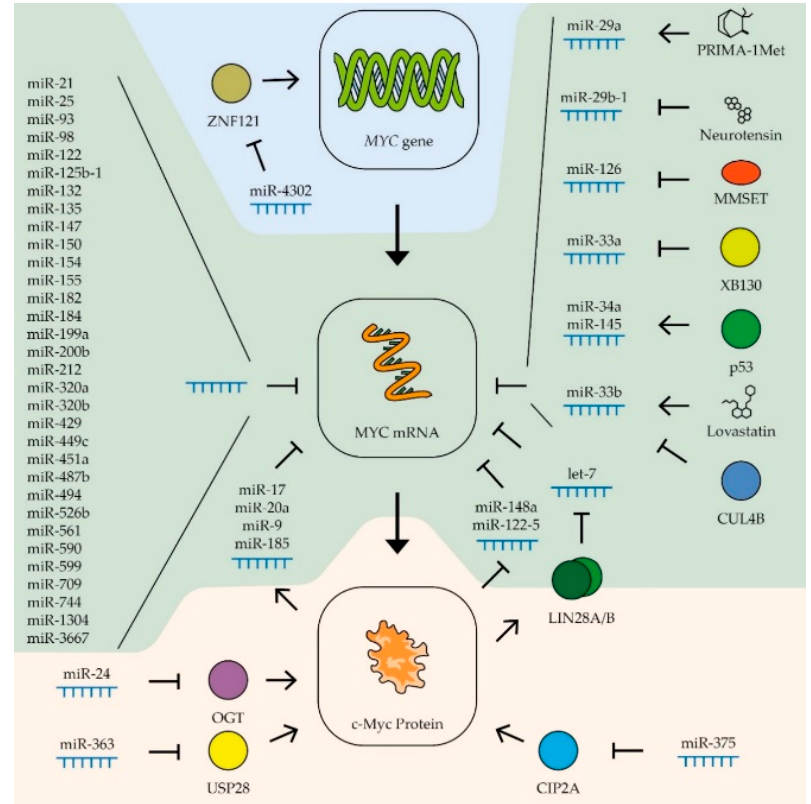
Figure 3. Control of MYC expression by miRNAs. Schematic representation of miRNAs’ influence on MYC gene transcription (blue zone), MYC mRNA (green zone), and c-Myc protein stability (yellow zone). Colored circles indicate the proteins included in the pathway. (See text for description and